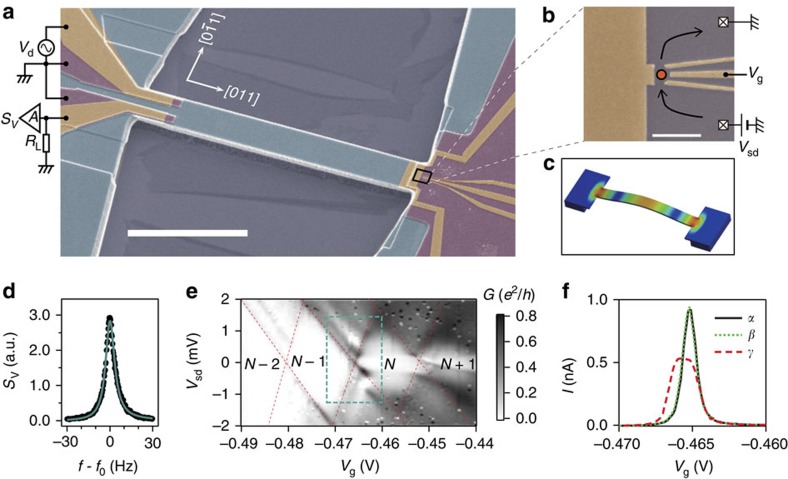
Hybrid mechanical resonator quantum dot system.(a) False-colour scanning electron microscope (FCSEM) image of the hybrid device along with the measurement setup (scale bar, 20 μm). A doubly clamped electromechanical resonator of 50 μm length, 6 μm width and 1 μm thickness is fabricated along the  crystal axis of GaAs. (b) FCSEM image of the Schottky gate electrodes defining the quantum dot at the right clamping point of the mechanical resonator (scale bar, 1 μm). Application of negative bias voltage to these gates depletes the underlying two-dimensional electrons and confines a few electrons within a small spacial area of <300 × 300 nm2 (red circle in b). (c) Finite element method simulation of the mechanical strain associated with the fundamental flexural mode's motion, showing the maximum strain at the clamping points. (d) The frequency response voltage power spectrum SV of the electromechanical transducer around the centre frequency f0=1664699.2 Hz of the fundamental flexural mode along with a Lorentzian fit (solid line). (e) A plot of the differential conductance of the quantum dot as a function of Vg and Vsd showing typical Coulomb diamonds as indicated by the red dashed lines. In each diamond, the number of electrons N in the QD are changed. In this study, we focus on the Coulomb peak enclosed by the blue square. (f) A Coulomb peak with the mechanical resonator under three different actuation conditions; α, no actuation; β, off-mechanical resonance actuation with Vd=150 μV at f=f0−100 Hz; γ, on-mechanical resonance actuation with Vd=150 μV.